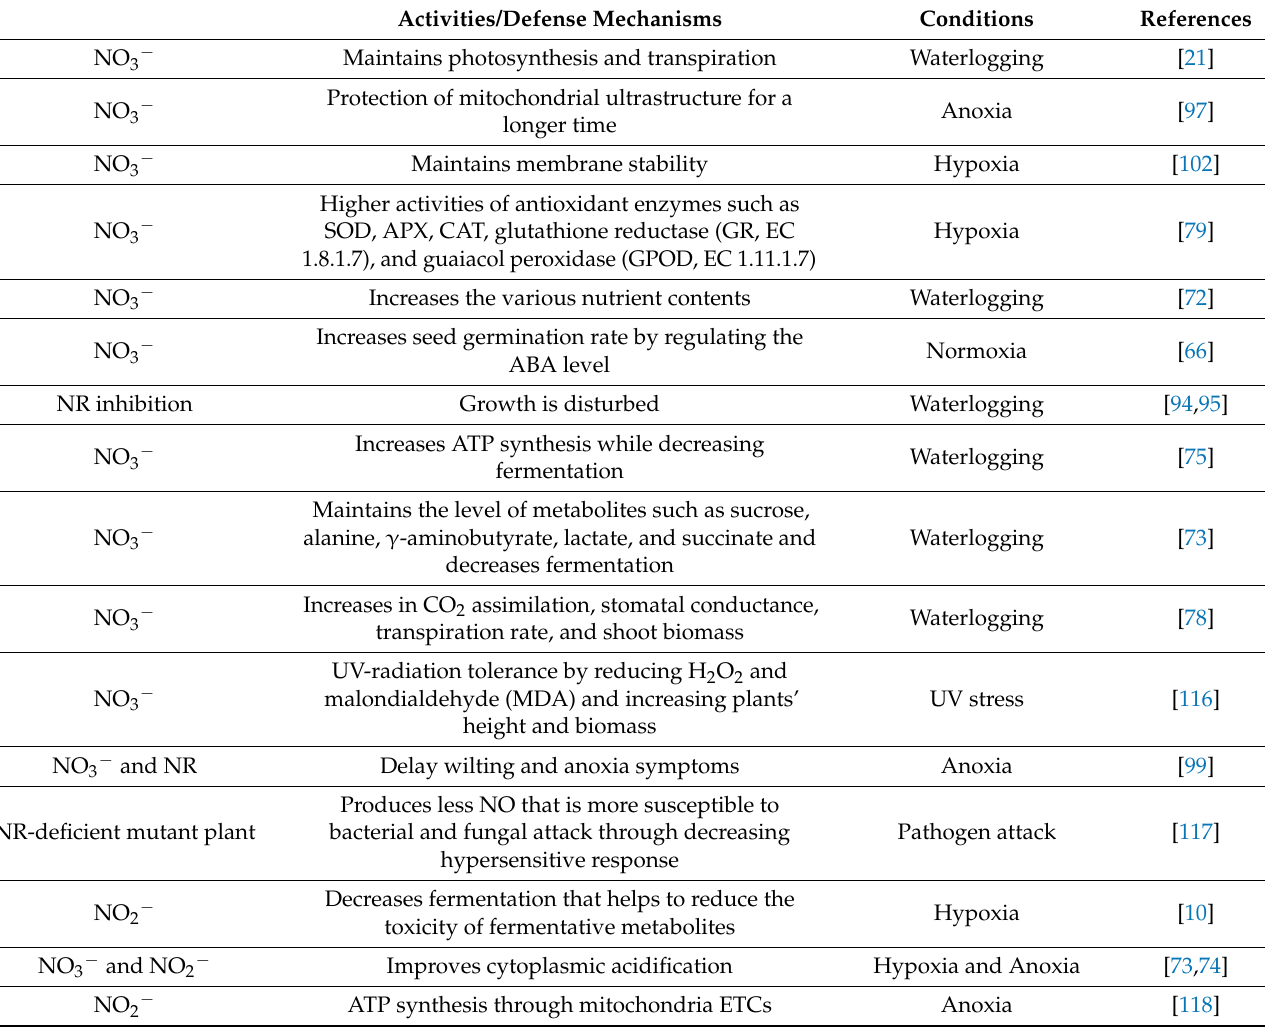
Table 1. Role of NO 3 -NO 2 -NO pathway during oxygen-limited conditions and other stresses on plant defense